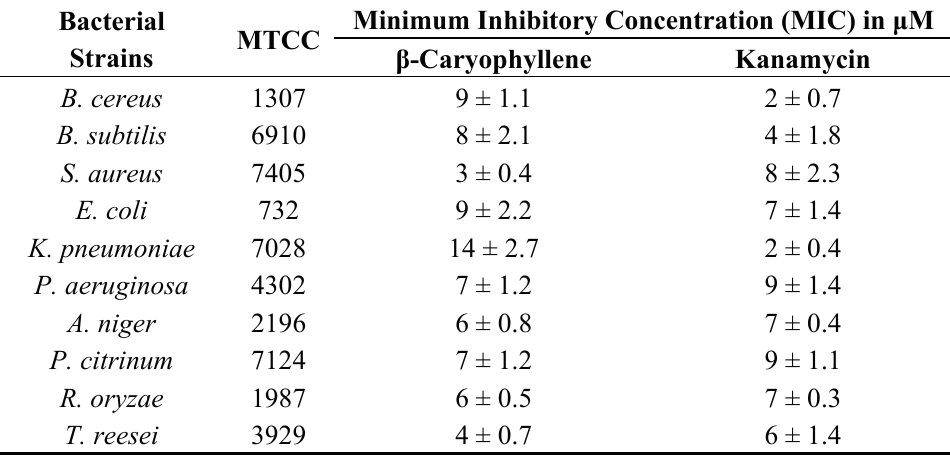
Figure 3. Antimicrobial effect of β -caryophyllene. ( A ) Antibacterial effect of β -caryophyllene ( β -C) on Staphylococcus aureus (Std = Kanamycin; EOs = essential oil of Aquilaria crassna ; NC = negative control); ( B ) Antifungal effect of β -caryophyllene ( β -C) on Trichoderma reesei (Std = Kanamycin; NC = negative control). Table 2. Antimicrobial activity of β